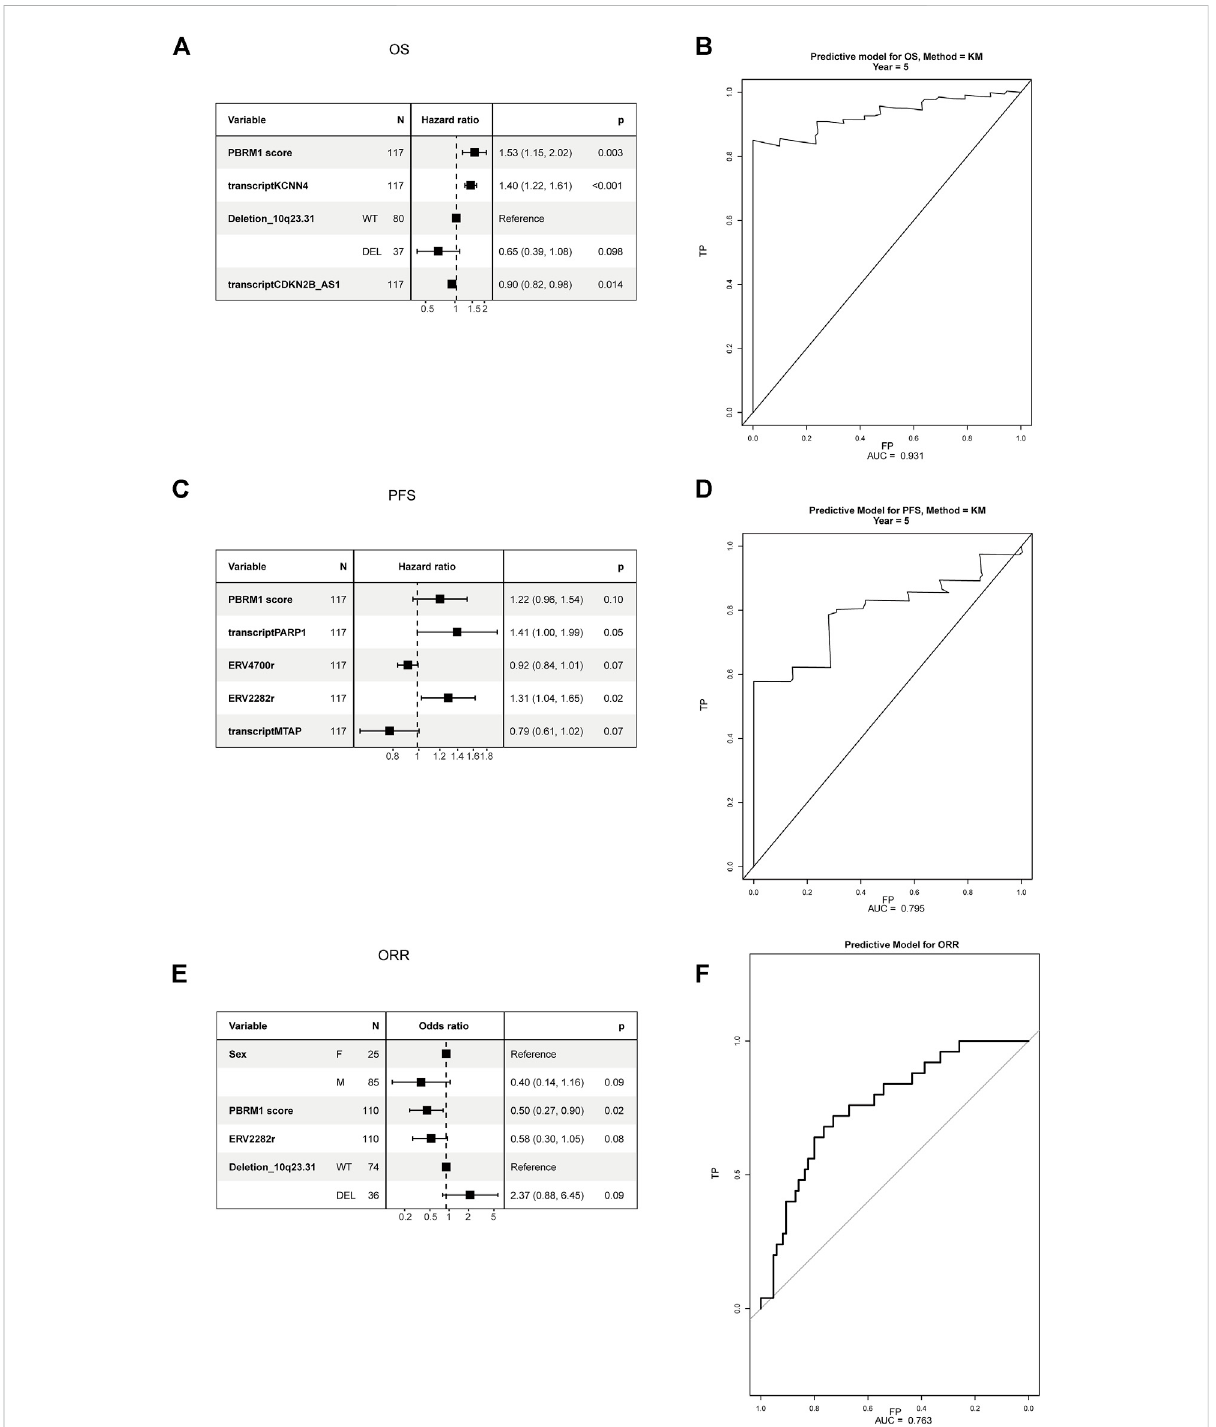
Multivariate analysis of candidate biomarkers in the PD-1 cohort. (A) The multivariate analysis based on Cox regression was used to assess the correlation between OS and candidate biomarkers in the PD-1 cohort. (B) The ROC curve of predictive model of OS. (C) The multivariate analysis based on Cox regression was used to assess the correlation between PFS and candidate biomarkers in the PD-1 cohort. (D) The ROC curve of predictive model of PFS. (E) The multivariate analysis based on logistic regression was used to assess the correlation between ORR and candidate biomarkers in the PD-1 cohort. (F) The ROC curve of predictive model of